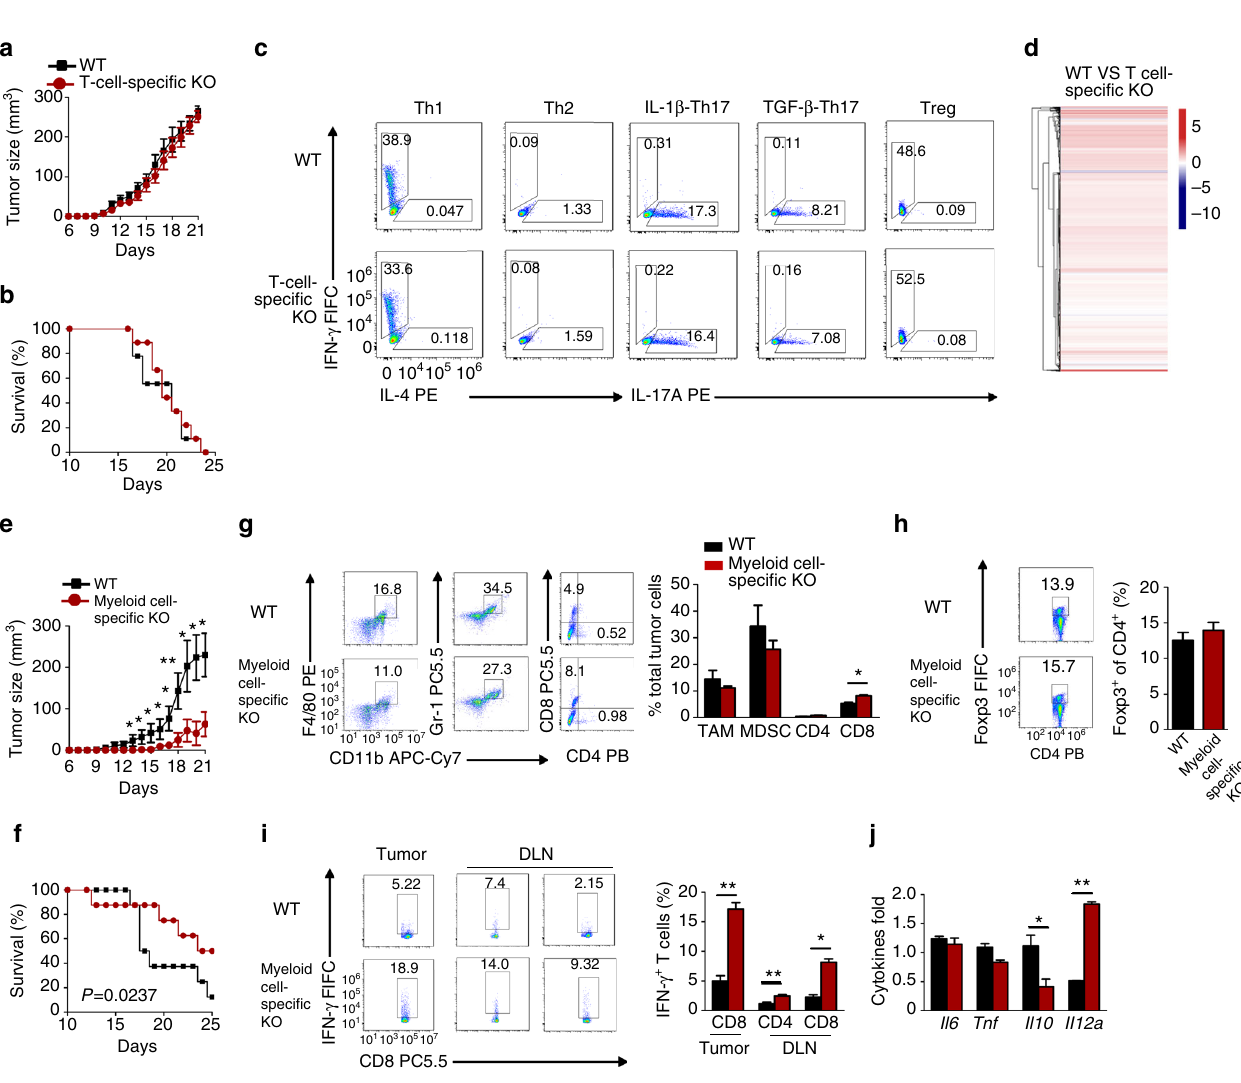
Fig. 3 FAM73b regulates anti-tumor responses in myeloid cells. a , b Tumor growth curve and survival curve of T-cell-speci fi c KO mice ( n = 8) injected with 2 × 10 5 B16 melanoma cells. c WT and T-cell-speci fi c KO naive CD4 + T cells (CD44 lo CD62L hi ) were stimulated for 4 days with plate-bound anti-CD3 and anti-CD28 antibodies under subpopulation conditions. The frequency of T-cell differentiation was analyzed by fl ow cytometry based on intracellular staining of cytokines. d Heat map showing basal differentially expressed genes in naive T cells from WT and T-cell-speci fi c KO mice. e , f Tumor growth curve ( e ) and survival curve ( f ) of myeloid cell-speci fi c KO ( n = 8) mice injected with 2 × 10 5 B16 melanoma cells. g , h Flow cytometric analysis of immune cells (CD45 + ) that in fi ltrated day 15 tumors and the frequency of CD4 + T cells, CD8 + T cells, macrophages (CD11b + F4/80 + ), myeloid derived suppressor cells (MDSCs) (CD11b + Gr-1 + ) ( g ) and Treg cells (CD4 + Foxp3 + ) ( h ). Summary of fl ow cytometry data based on multiple animals, showing the frequency of the indicated cell populations within total tumor cells (right panel). i ICS and fl ow cytometric analysis of IFN γ + in CD8 + T tumor or dLN cells, presented as a representative plot (left panel) and a summary graph (right panel). j qRT-PCR analysis of the indicated genes in TAMs isolated from tumors in WT or myeloid cell-speci fi c KO mice. All qRT-PCR data are presented as fold-induction relative to the Actb mRNA level. The data are the mean ± SEM value of multiple animals (each circle or square represents a mouse) and representative of three independent experiments. Two-tailed unpaired t -tests were performed. * P < 0.05; ** P <